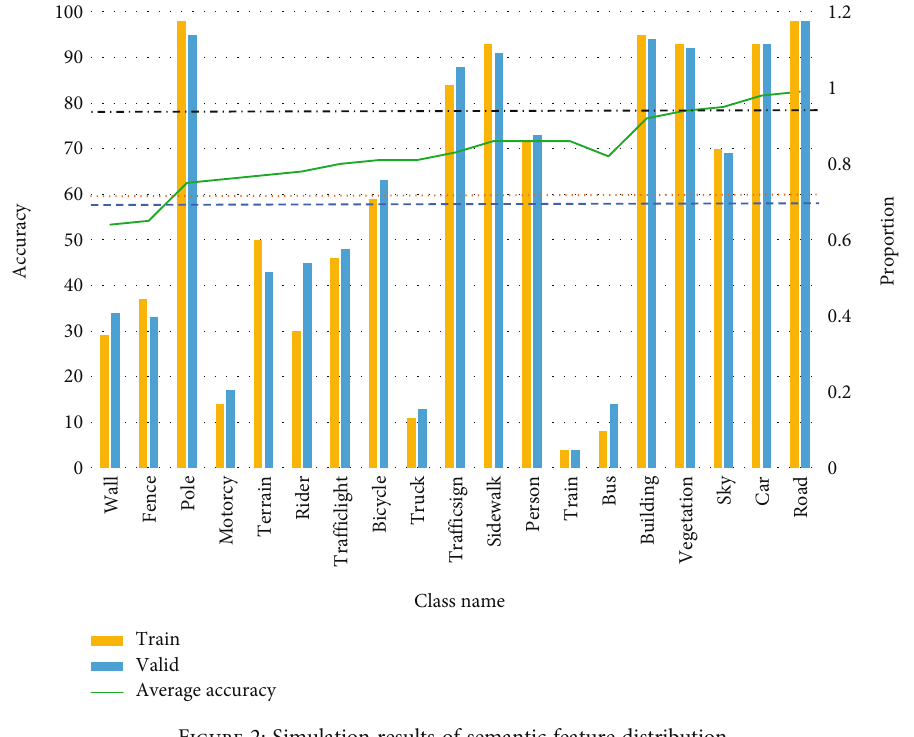
Figure 2: Simulation results of semantic feature